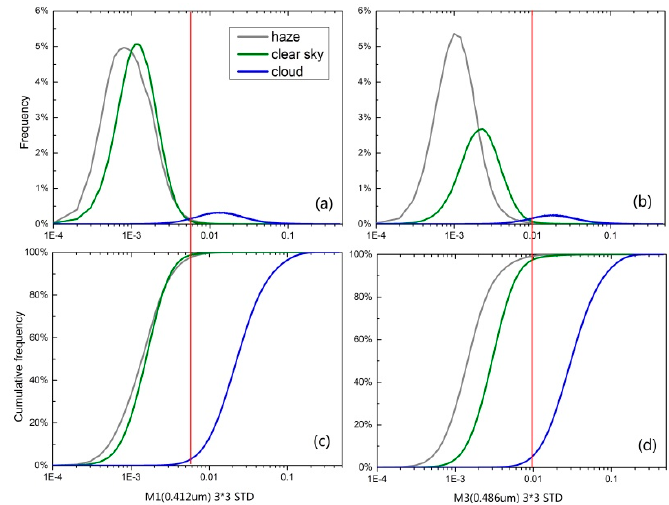
Figure 6. Histograms ( a , b ) and cumulative histograms ( c , d ) of the ρ TOA STD in the VIIRS bands M1 (left column) and M3 (right column) for three types of pixels, including clouds (blue), haze (grey), and clear sky (green). The red lines are the suggested thresholds of the spatial variability test, which are 0.005 for M1 and 0.01 for M3.